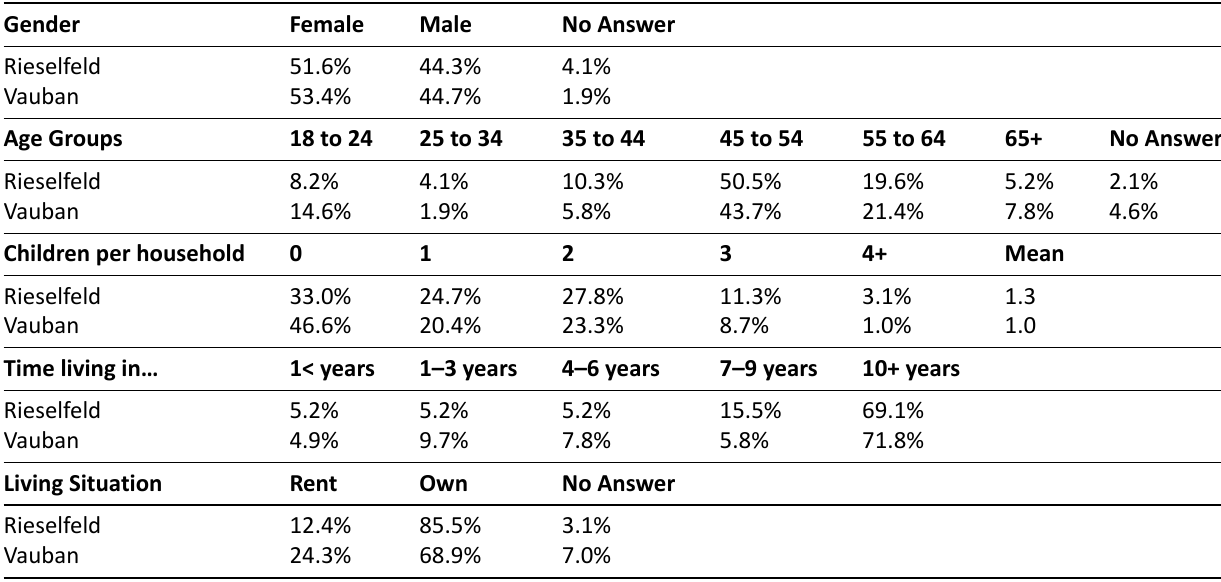
Table 2. Characteristics of surveyed